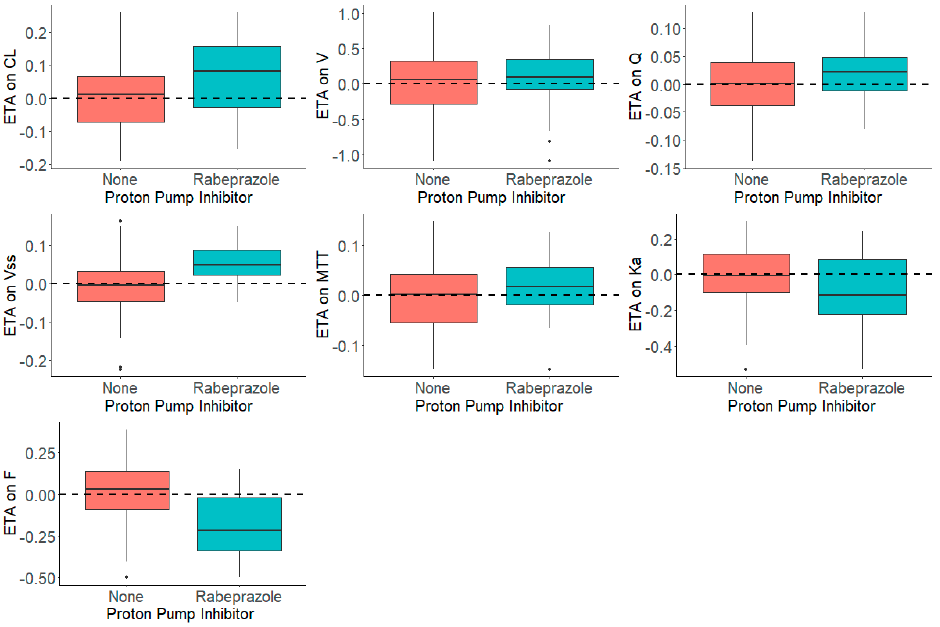
Figure 3. Distribution of η s (ETAs) by the Presence and Absence of Proton Pump Inhibitor, Rabeprazole, in the Dacomitinib Base Model.